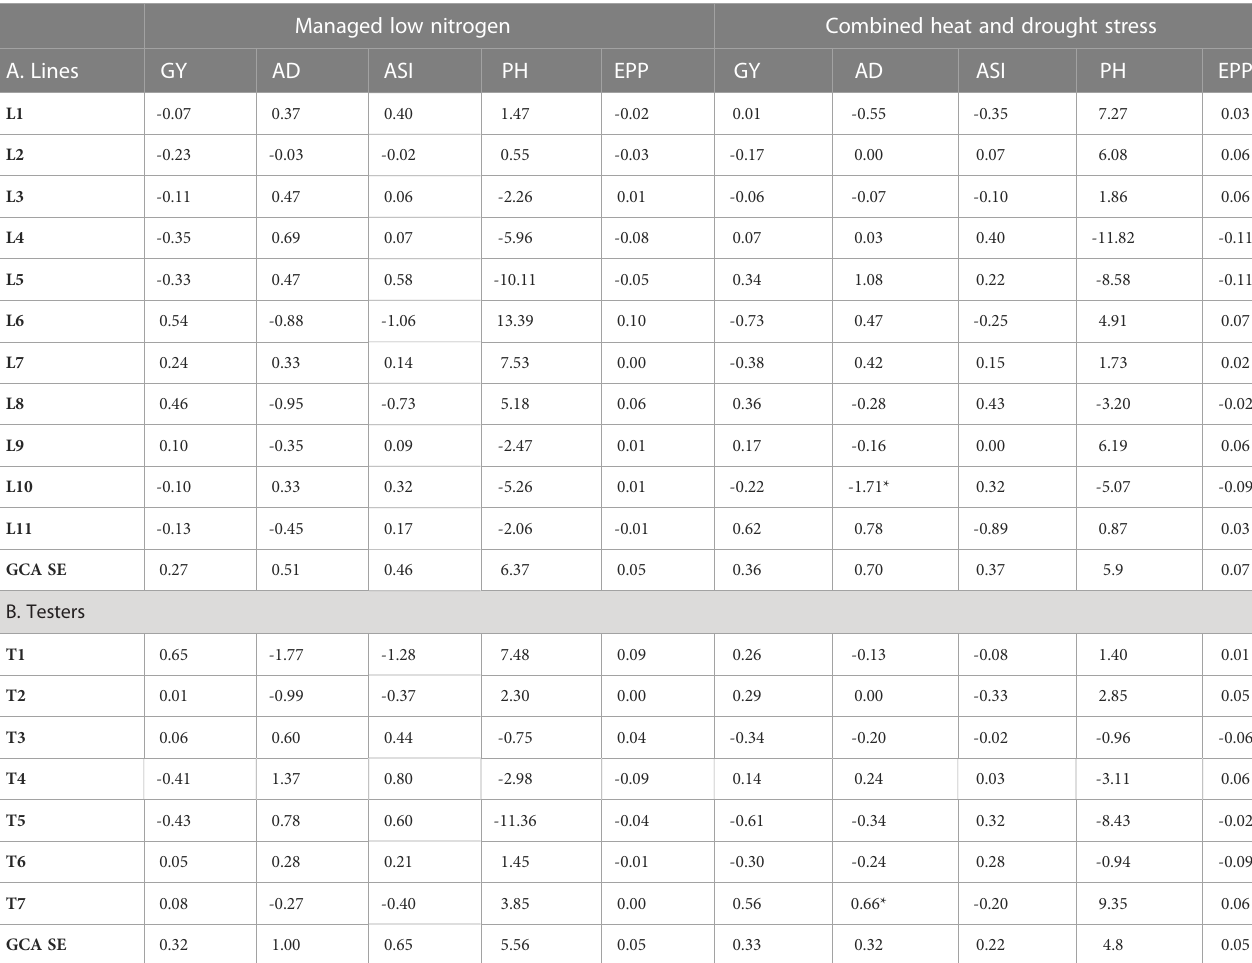
TABLE 8 Estimates of lines and tester GCA effects for grain yield and other agronomic traits under managed low N and combined heat and drought conditions.